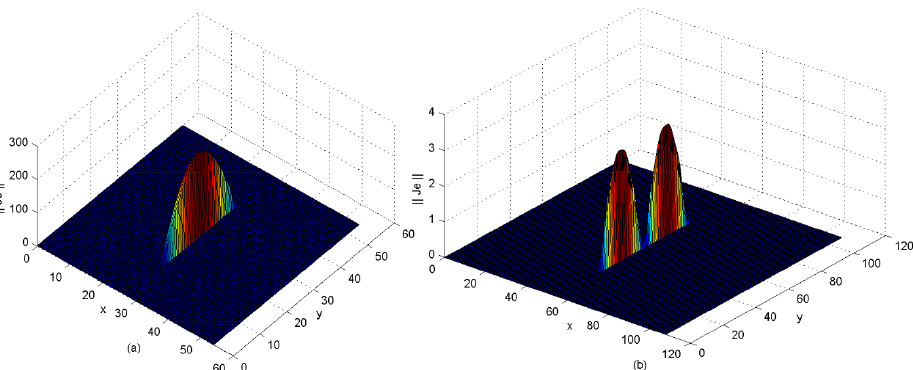
Figure 5. Validation of the evaluated input impedance obtained by the MoM-GEC and the HFSS tool for a unit cell of a dipole: α 0 = 0 rad m − 1 , β 0 = 0 rad m − 1 , w = 1 mm, δ = 0.75 mm ( w (cid:28) λ 0 , δ (cid:28) λ 0 ) , d x = 108 mm, d y = 108 mm, L = λ 0 ≈ 54 mm ( at the fixed frequency f = 5.4 GHz ) , h = 1.25 mm, and (cid:101) = (cid:101) r = 1 (air).